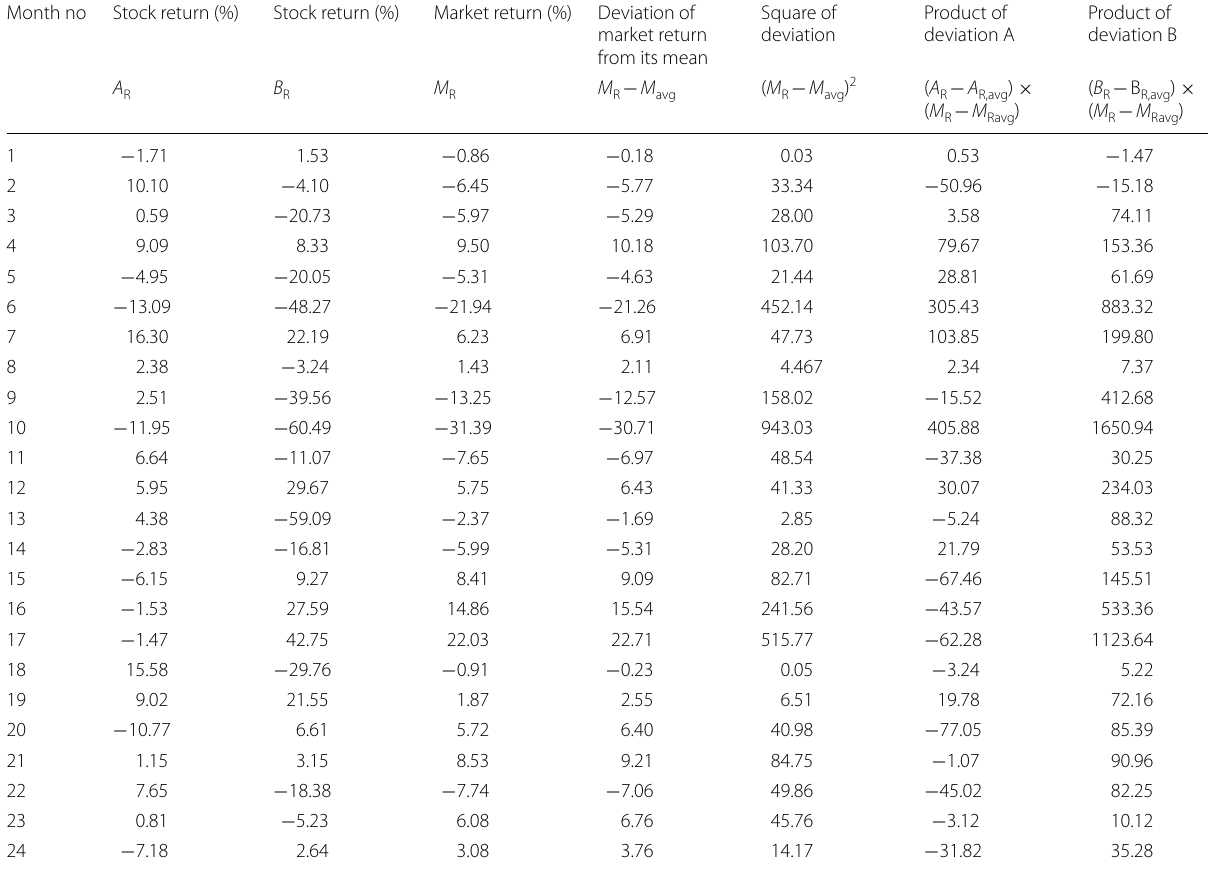
Table 2 Covariance calculation for stocks A and B with respect to market